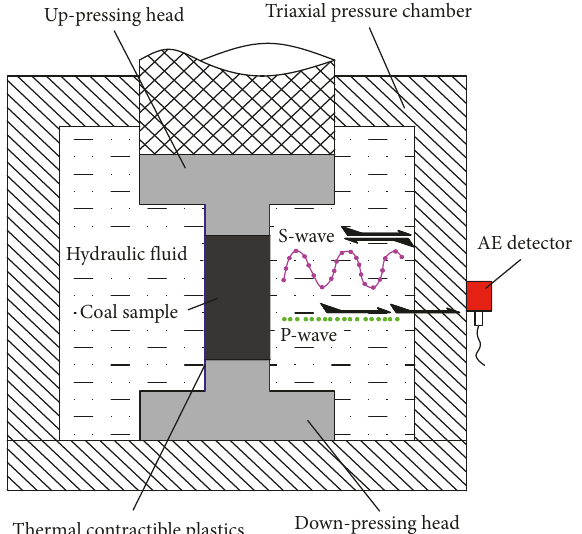
Figure 2: AE detector placed on the surface of rock samples or coal samples in the triaxial